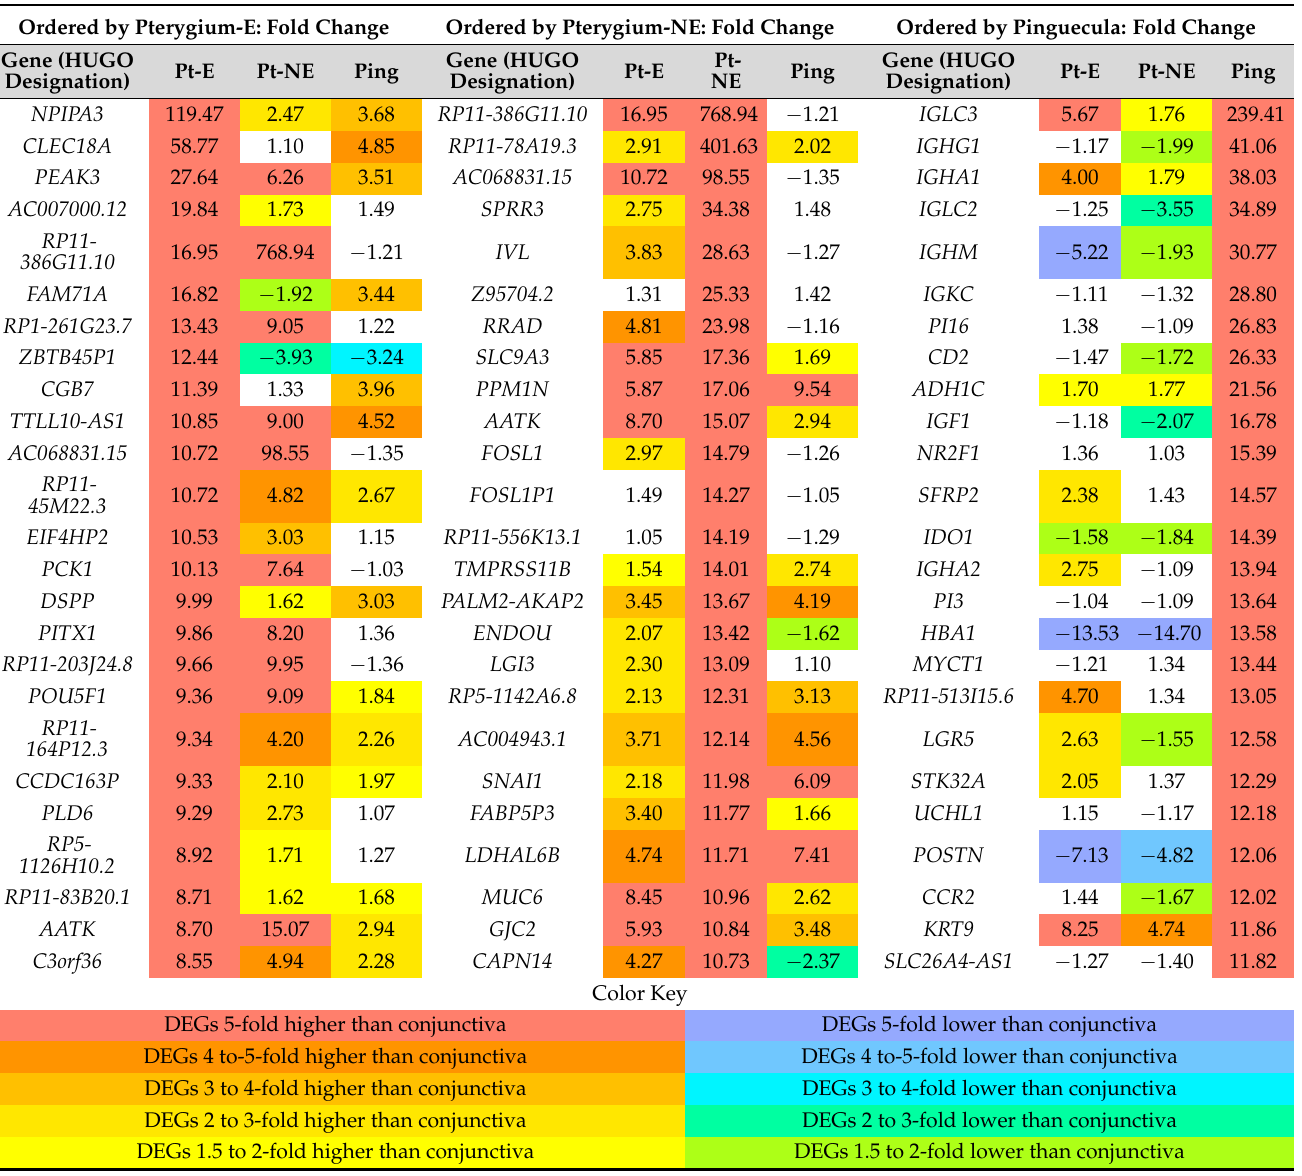
Table 2. Top 25 Genes Upregulated with Respect to Normal